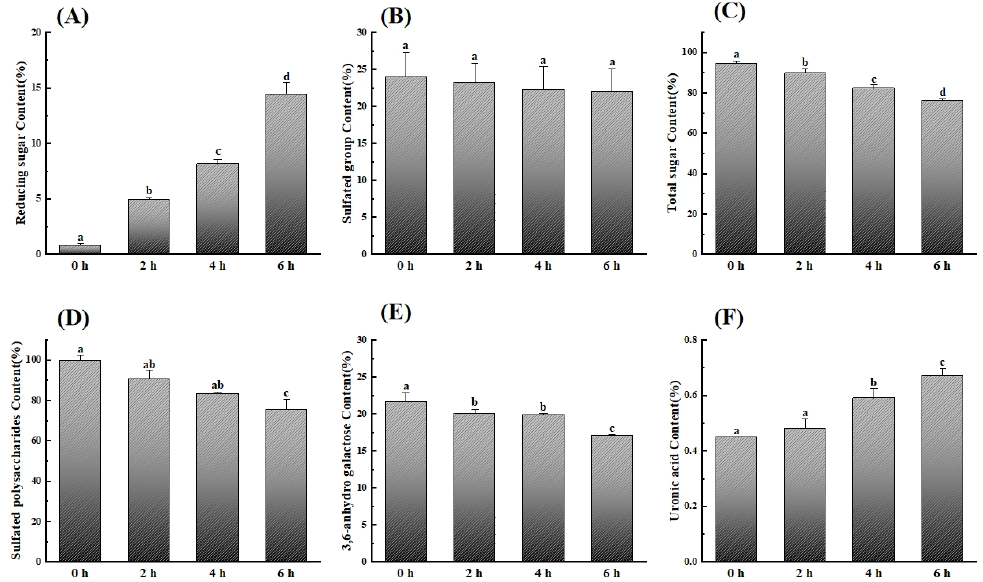
Figure 3. Changes in chemical compositions of κ -carrageenan. ( A ) Reducing sugar content, ( B ) sulfated group content, ( C ) total sugar content, ( D ) sulfated polysaccharide content, ( E ) 3,6-anhydro galactose content, and ( F ) uronic acid content. Data are expressed as the mean ± SD (n = 3). Graph bars marked with different letters on top represent statistically significant results ( p < 0.05) based on one-way analysis of variance (ANOVA) with Duncan’s range tests, whereas bars marked with same letter correspond to results that show no statistically significant differences.